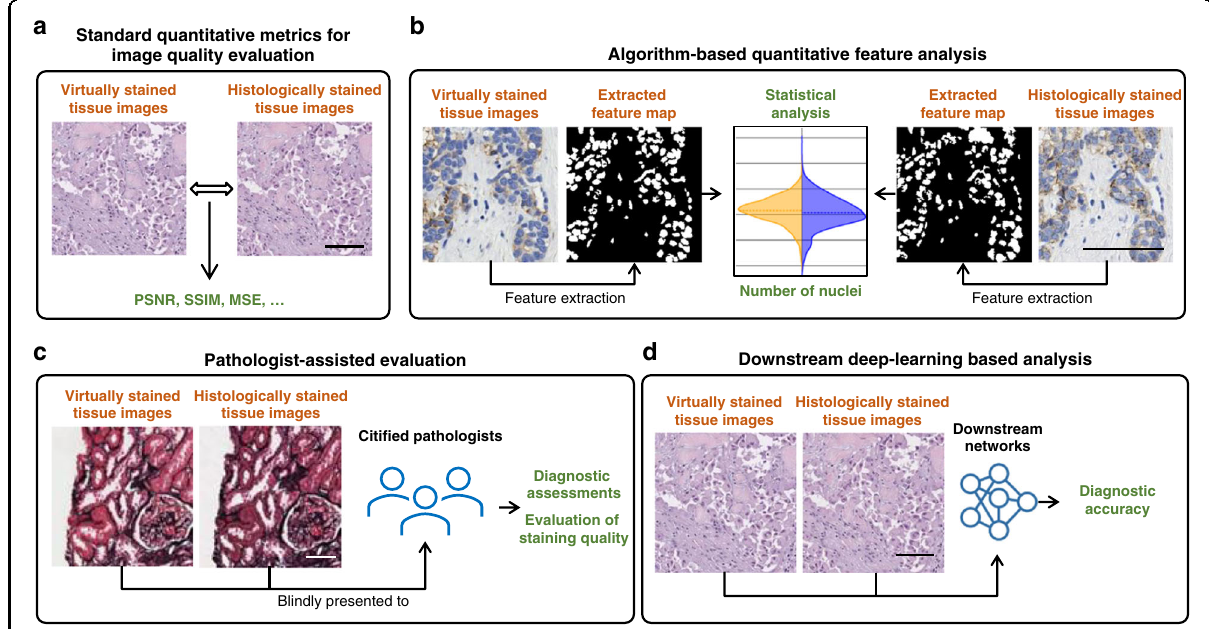
Fig. 8 Evaluation methods for virtual staining neural network models. a Standard quantitative metrics such as PSNR and SSIM are calculated based on output images and their corresponding ground truth images. b Pathological features are extracted, and the statistical correlations between the features from the virtual and histological staining methods are compared. c The diagnostic values and the staining quality of the virtually generated images are evaluated by expert pathologists and compared against the histologically stained ones. d Validated digital pathology DNN models that can perform downstream diagnostic analysis are used to evaluate the clinically relevant characteristics of virtually and histologically stained